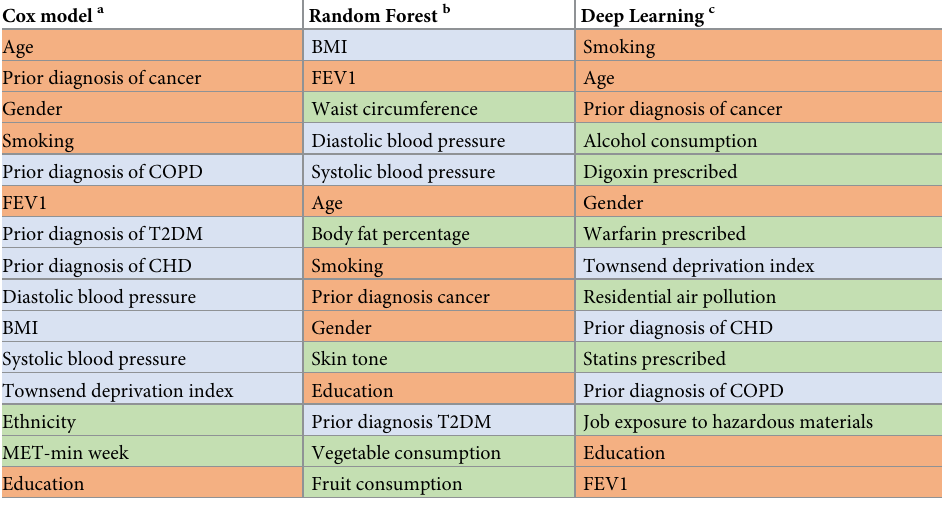
Diastolic blood pressure Prior diagnosis cancer Residential air pollution BMI Gender Prior diagnosis of CHD Prior diagnosis of COPD Ethnicity Prior diagnosis T2DM Job exposure to hazardous materials MET-min week Vegetable consumption Education Education Fruit consumption FEV1 a ranking determined by strongest to weakest Cox regression coefficients b ranking determined by largest to smallest mean decreases in accuracy c ranking determined by largest to smallest scaled importance derived from network weights orange = top risk factor in all three algorithms; blue = top risk factor in two algorithms; green = top risk factor in